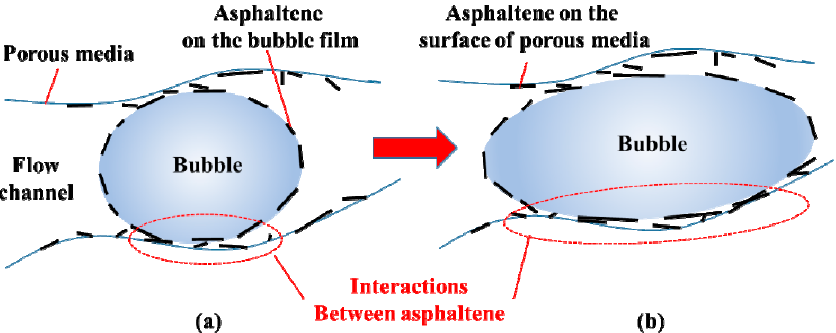
Figure 16. Schematic showing how interactions between the asphaltene on the bubble film and on the surface of porous media promote the bubble to deform and stretch. ( a ) Interlacement between the asphaltenes on the bubble film and on the surface of porous media; ( b ) Bubble deformation and stretch happens due to the